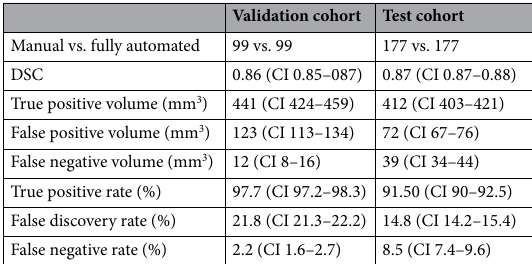
Table 2. Performance of the proposed 3D U-Net for the automatic segmentation of the inner ear. True positive volume: the volume correctly segmented as the inner ear, false negative volume: the volume incorrectly not segmented as the inner ear (under segmentation). False positive volume: the volume incorrectly segmented outside the inner ear (over segmentation) true positive rate: the percentage of voxels correctly segmented as the inner ear, false discovery rate: the percentage of voxels incorrectly segmented outside the inner ear (over segmentation), false negative rate: the percentage of voxels incorrectly not segmented as the inner ear (under segmentation). CI 95% confidence